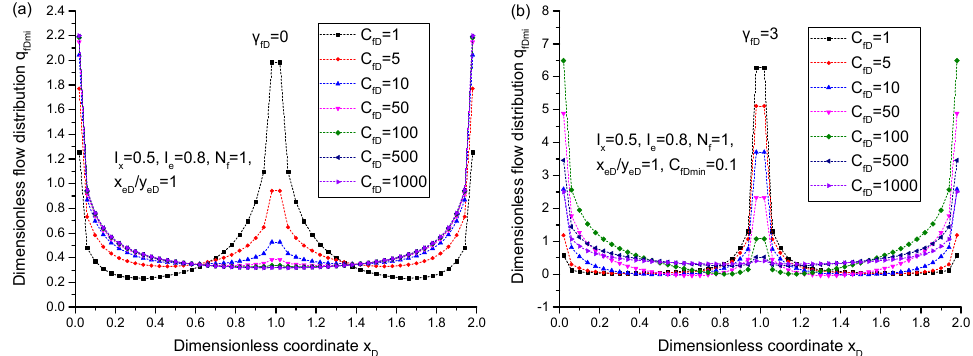
Figure 14. Influence of dimensionless conductivity on influx-flow distribution ( a ) with and ( b ) without the pressure-sensitivity effect.